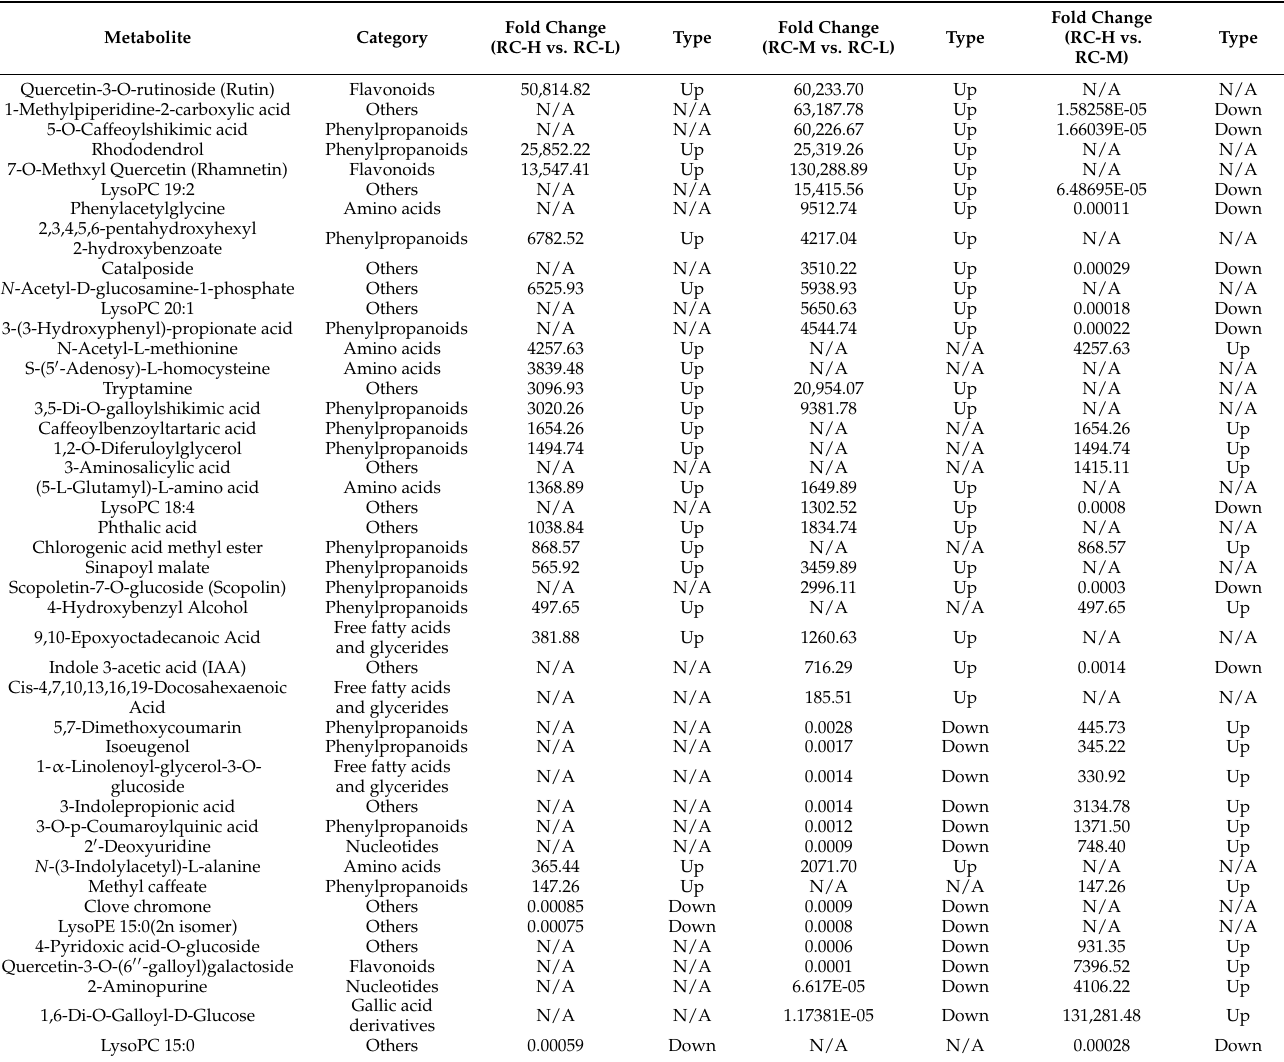
Table 2. Biomarkers for Rhodiola crenulata from altitude of 3933–4531 m (RC-H vs. RC-L; RC-M vs. RC-L; RC-H vs. RC-M).